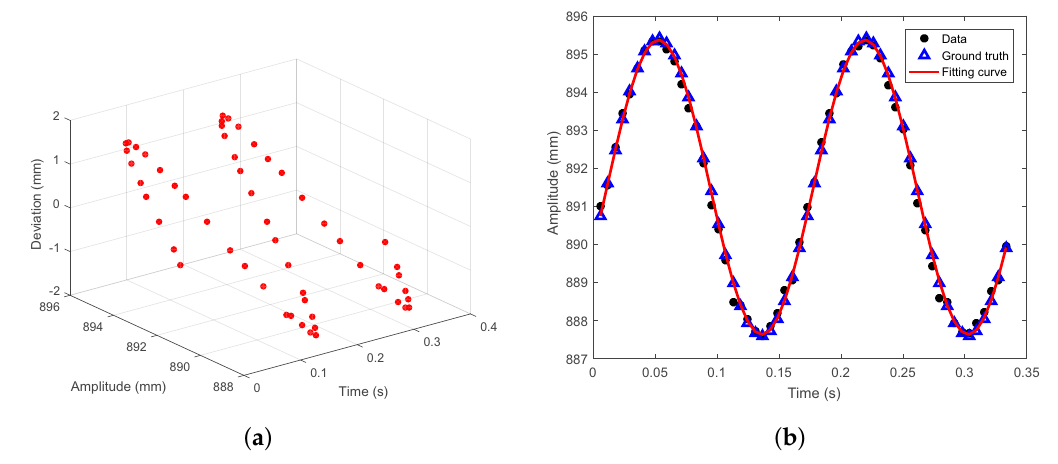
Figure 3. ( a ) 3D Reconstruction results; and ( b ) the projection in